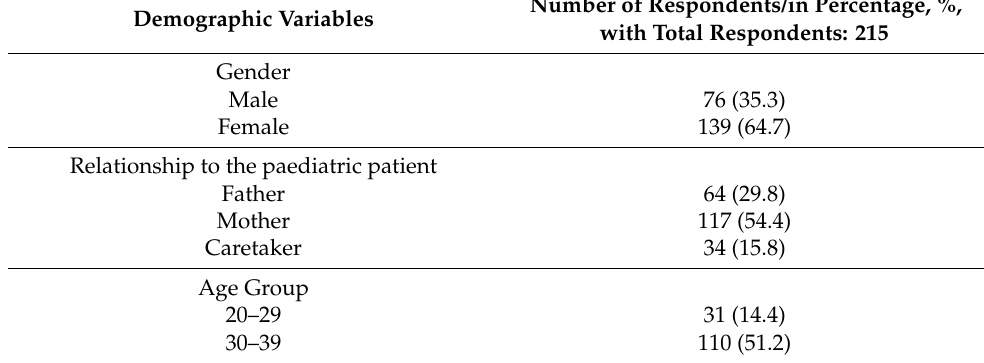
Table 1. Demographics of respondents in the survey. Demographic